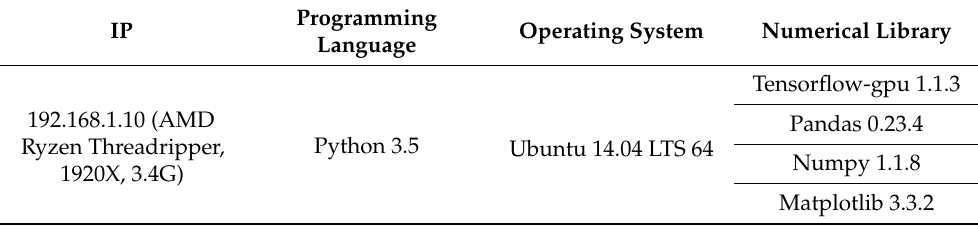
Table 8. Experimental environment for TCN-based prediction